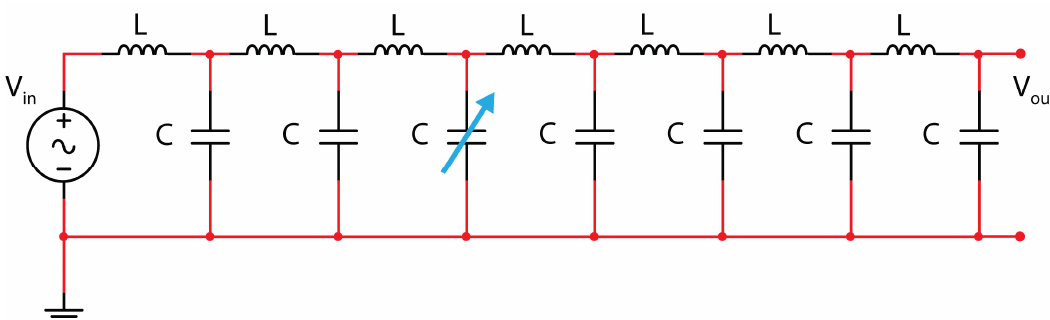
Figure 7. The L–C seven-cell L.N. with a variation of C in the third cell.